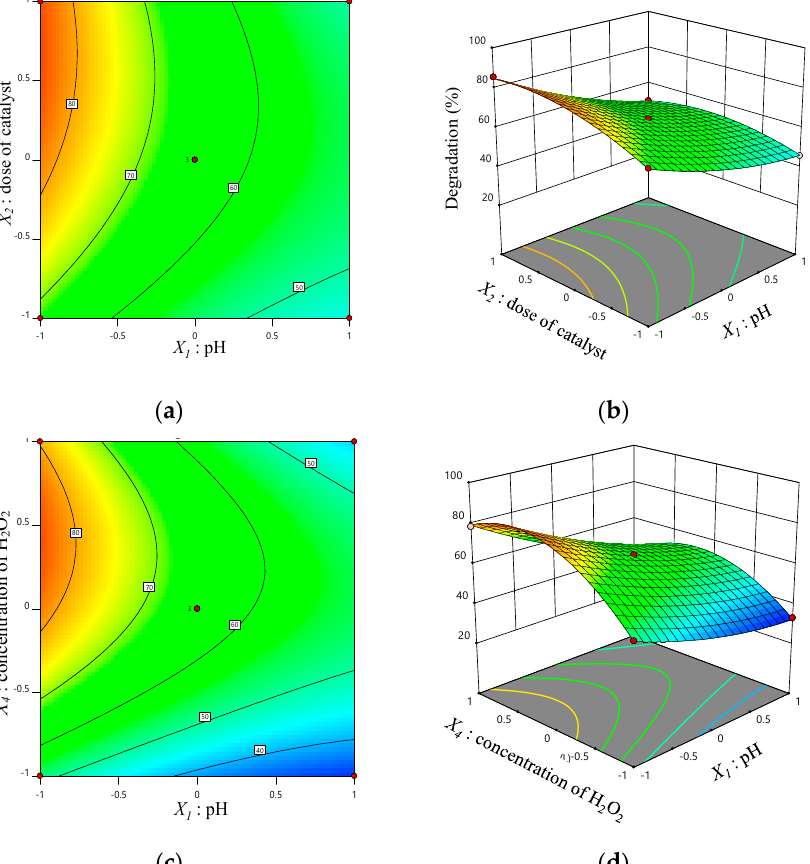
Figure 8. Response surface graphs and plots for photocatalytic degradation (%): ( a , b ) between pH and catalyst dose with the remaining factors fixed at 0.084 mM MO concentration and 333 mg/L H 2 O 2 concentration, and ( c , d ) between pH and H 2 O 2 concentration with the remaining factors fixed at 0.3 g/L catalyst dose and 0.084 mM MO concentration.